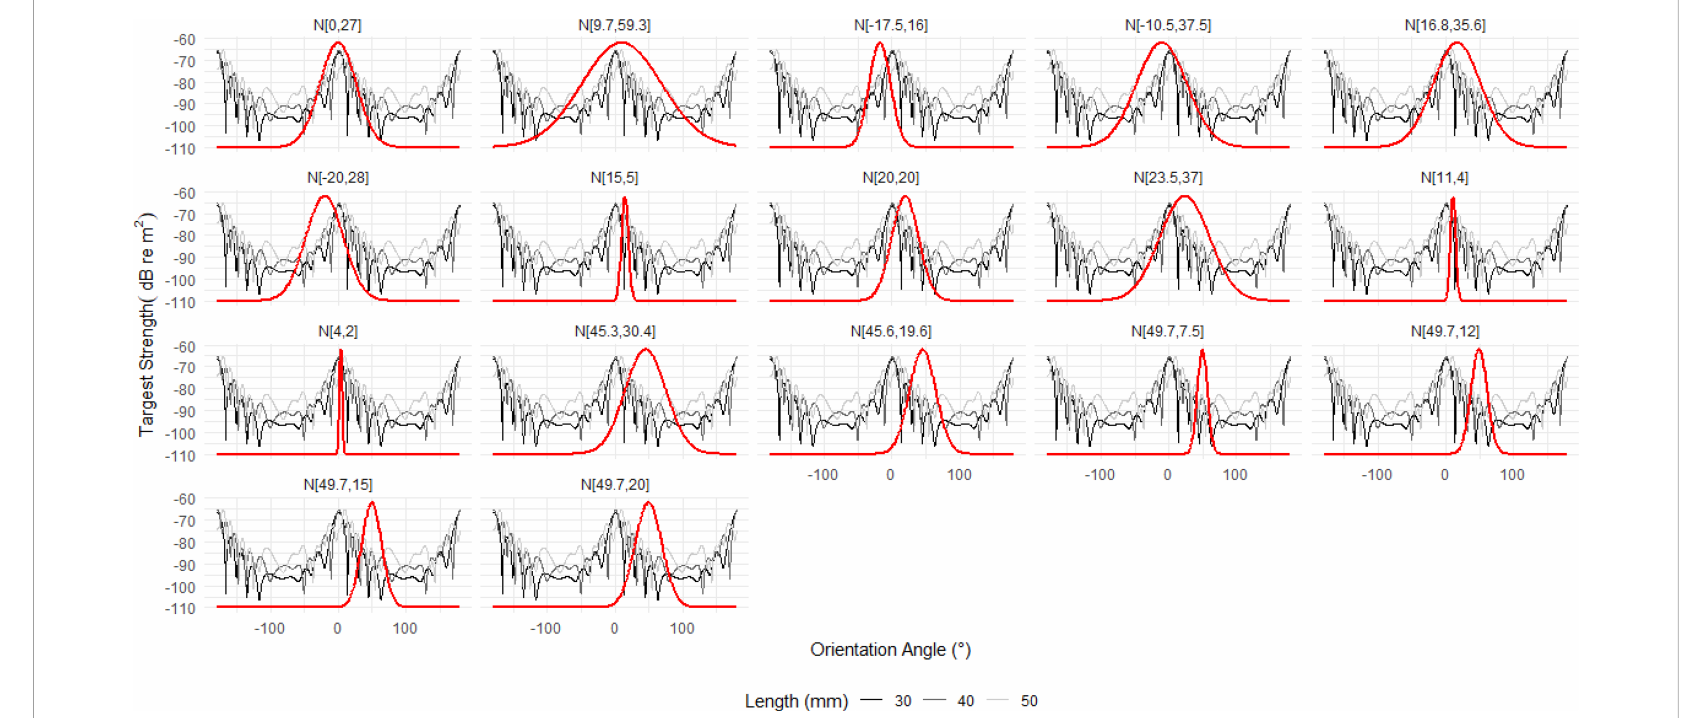
FIGURE 13 The relationship between target strength (TS) and orientation angle for the average krill shape with lengths 30, 40 and 50 mm is shown for reference. Each panel is overlaid with a Gaussian orientation distribution (solid red line) in the form N[theta,St.Dev], where theta is the mean orientation angle and St.Dev is the standard deviation. The fi rst fourteen orientation distributions are literature values. Of these, N [49.7°,7.5°]falls almost entirely within a region of TS nulls resulting in atypically calculations of the conversion factor. The three addition distributions are the result of increasing the standard deviation of N [49.7°,7.5°] to 12°, 15°, and 20° which broadens the distribution to include more typical TS